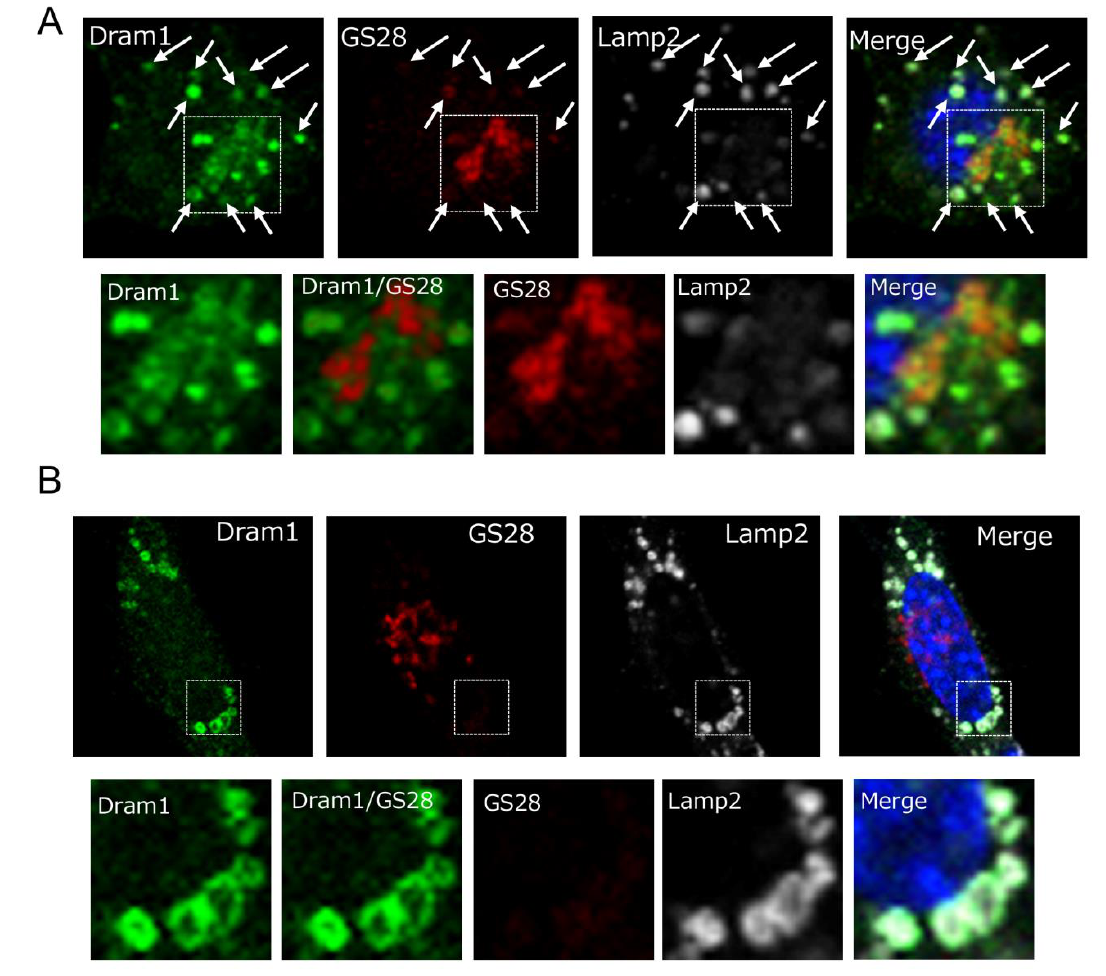
FIGURE 4: Intracellular localization of Dram1-Flag in Atg5 KO MEFs. Atg5 KO MEFs were transfected with dram1-flag for 24 h (A) and 48 h (B) . The cells were then examined for immunofluorescence of GS28 (a pan-Golgi marker), Lamp2 (a lysosome marker), and Flag (Dram1). Nuclei were counterstained with DAPI. In (A) , some Dram1 particles were merged with GS28 signals (dashed squares). Magnified images of the area within the dashed squares are shown in the bottom panels. Arrows indicate areas of Dram1 and Lamp2 colocalization. In (B) , none of the Dram1 particles were merged with GS28 signals (dashed squares). Magnified images of the area within the dashed squares are shown in the bottom